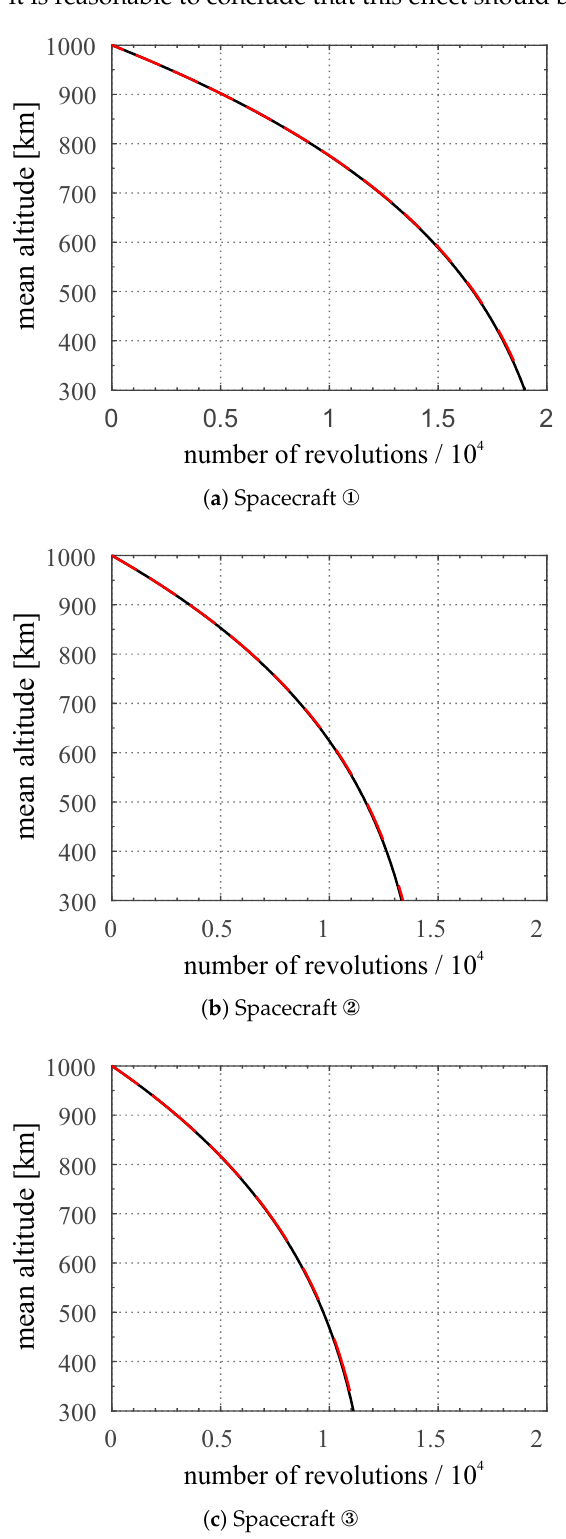
Figure 7. Deorbiting profiles from 1000km to 300km of three different spacecrafts, see Table 1 (solid black line = numerical integration; dashed red line = approximate